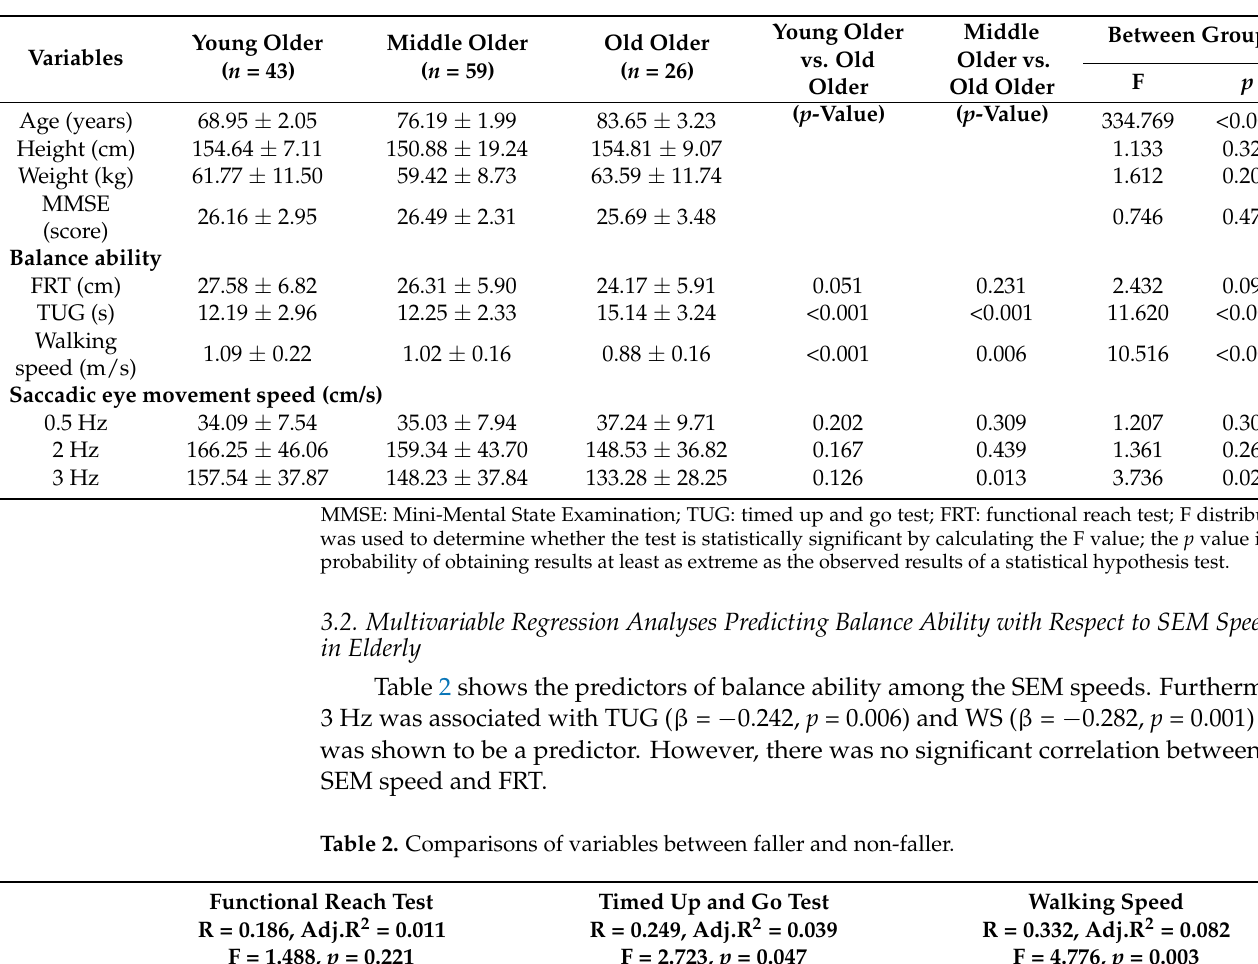
Table 1. Comparisons of variables according to age.